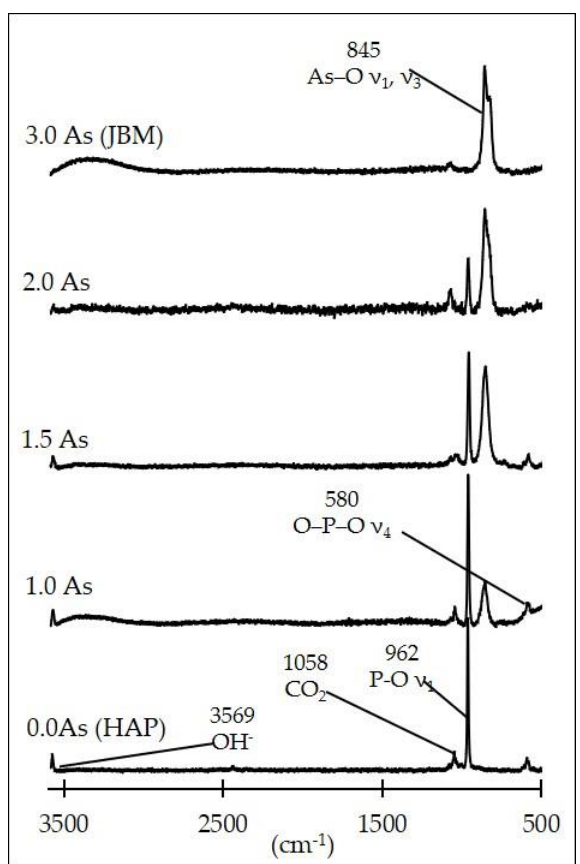
Figure 3. Linear variation of the unit cell parameters a , c , and V in the JBM–HAP solid solution series.